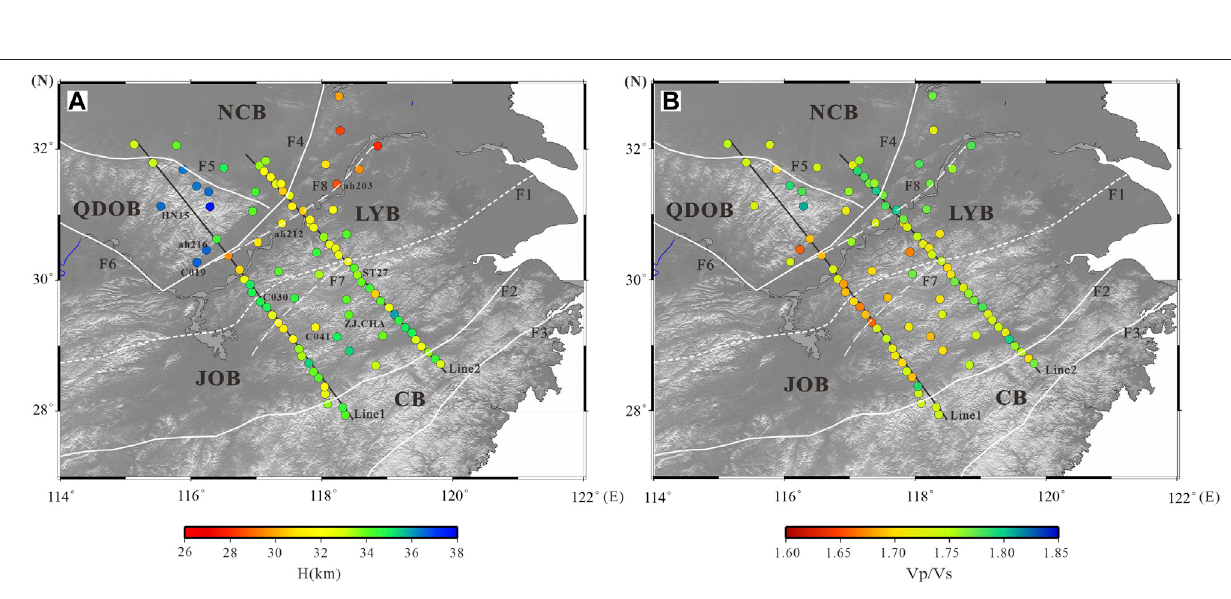
Frontiers in Earth Science |